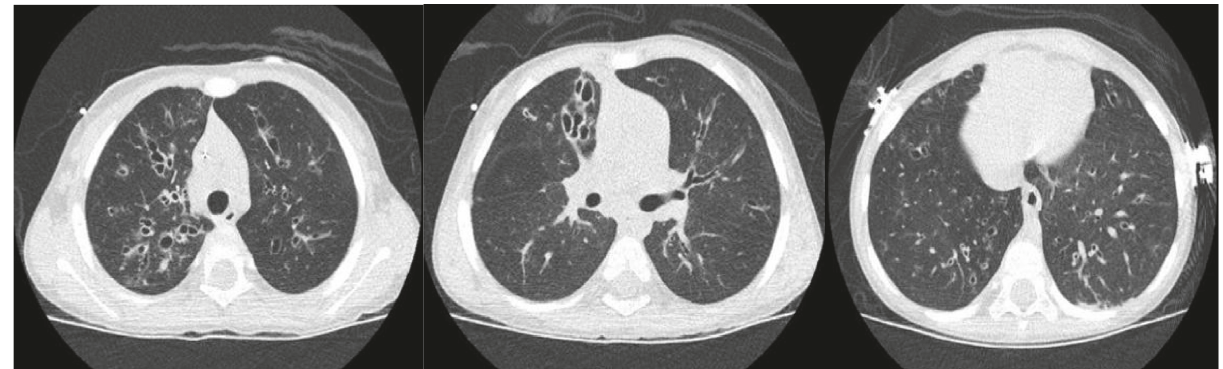
Figure 1: High-resolution computed tomography of the chest showing diffuse bilateral cylindrical/cystic bronchiectasis more pronounced in the upper lobes/right middle lobe than lower lobes with associated scattered areas of air